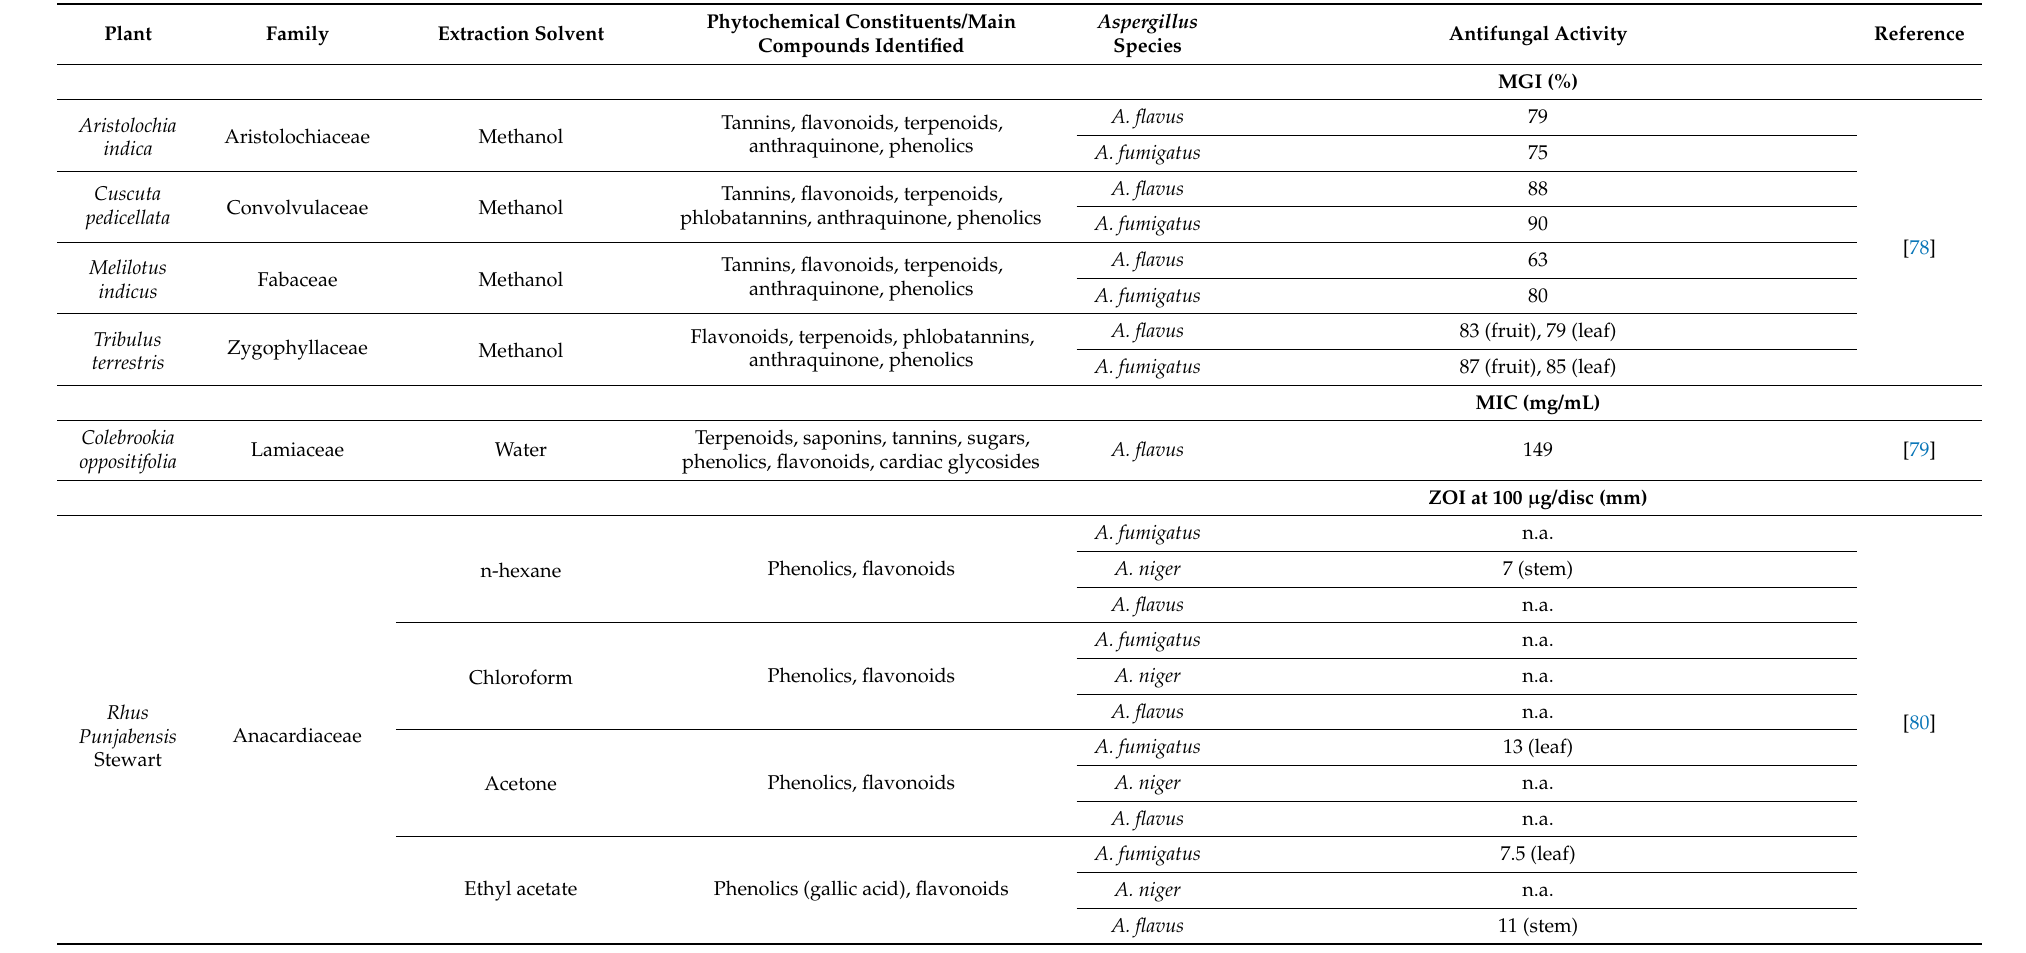
Table 1. Antifungal effects of plant crude extracts against Aspergillus